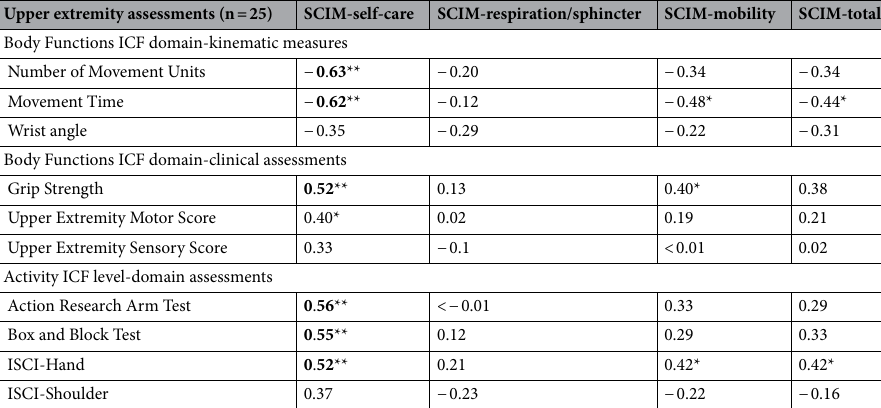
Table 3. Spearman coefficients for Spinal Cord Independence Measure (SCIM) subscale scores and upper extremity assessments. ** P < 0.01 * P < 0.05 Correlation coefficients > 0.5 are marked with bold. ICF International Classification of Functioning, Disability and Health, ISCI International Spinal Cord Injury Upper Extremity Basic Data Set Form, ISCI-Hand basic Hand variable, ISCI-Shoulder Shoulder variable, SCIM Spinal Cord Independence